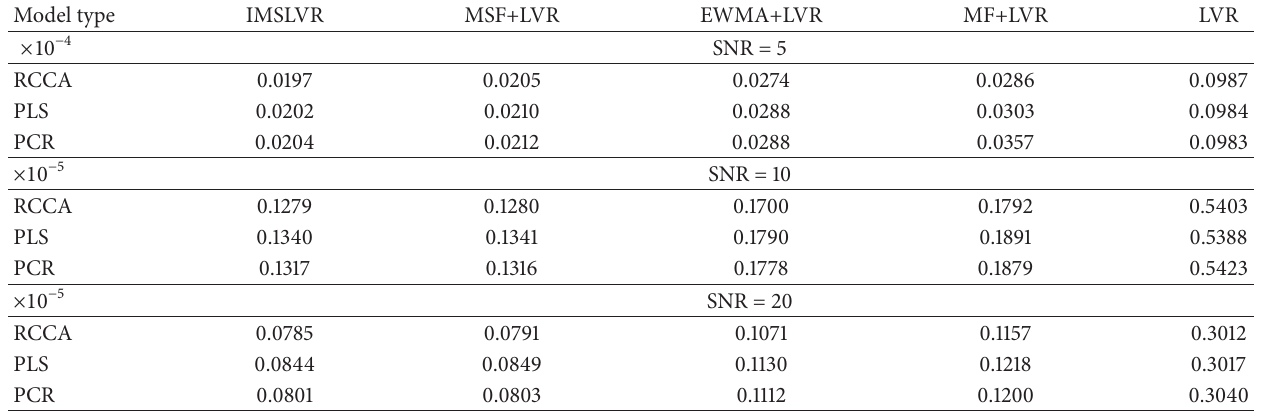
Table 3: Comparison of the Monte Carlo MSE’s for 𝑥 𝐷 in the simulated distillation column